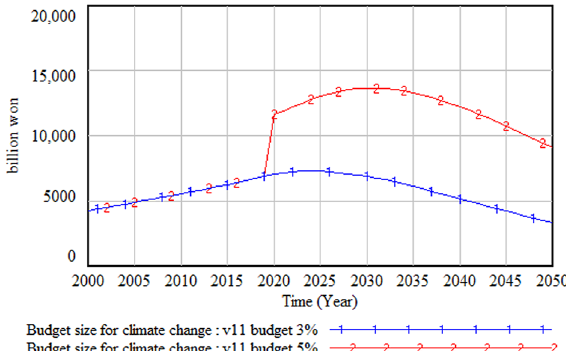
Figure 25. Climate budget change.